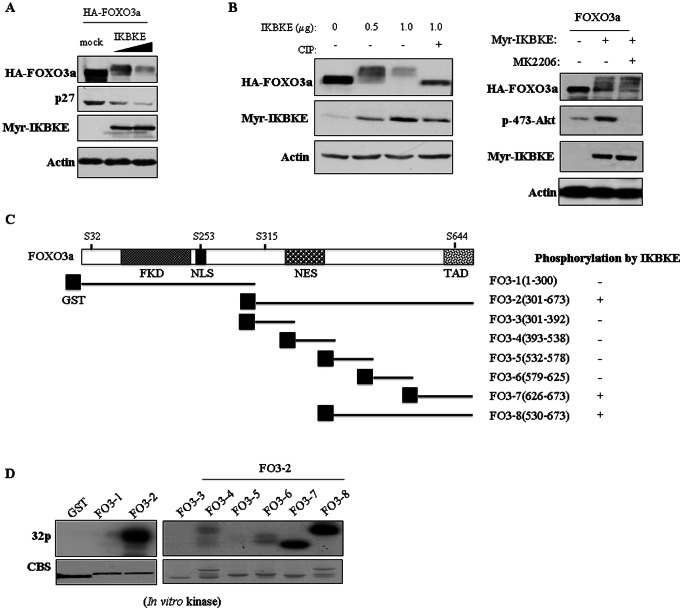
IKBKE phosphorylates FOXO3a.(A and B) IKBKE induces FOXO3a mobility shift which is inhibited by protein phosphatase CIP but not MK2206. H1299 cells were transfected with indicated plasmids. Following treatment with and without MK2206, cells were lysed. A portion of cell lysate was treated with CIP at 37°C for 30 min prior to SDS-PAGE electrophoresis (lane 5 of B). Immunoblots were probed with indicated antibodies. (C) A diagram illustration of GST-FOXO3a fusion proteins. (D) C-terminal region of FOXO3a was phosphorylated by IKBKE. In vitro kinase was performed by incubation of recombinant IKBKE with indicated GST-FOXO3a fusion proteins (top). Bottom panel is coomassie blue staining (CBS) showing GST-FOXO3a fusion proteins used for in vitro IKBKE kinase assay.